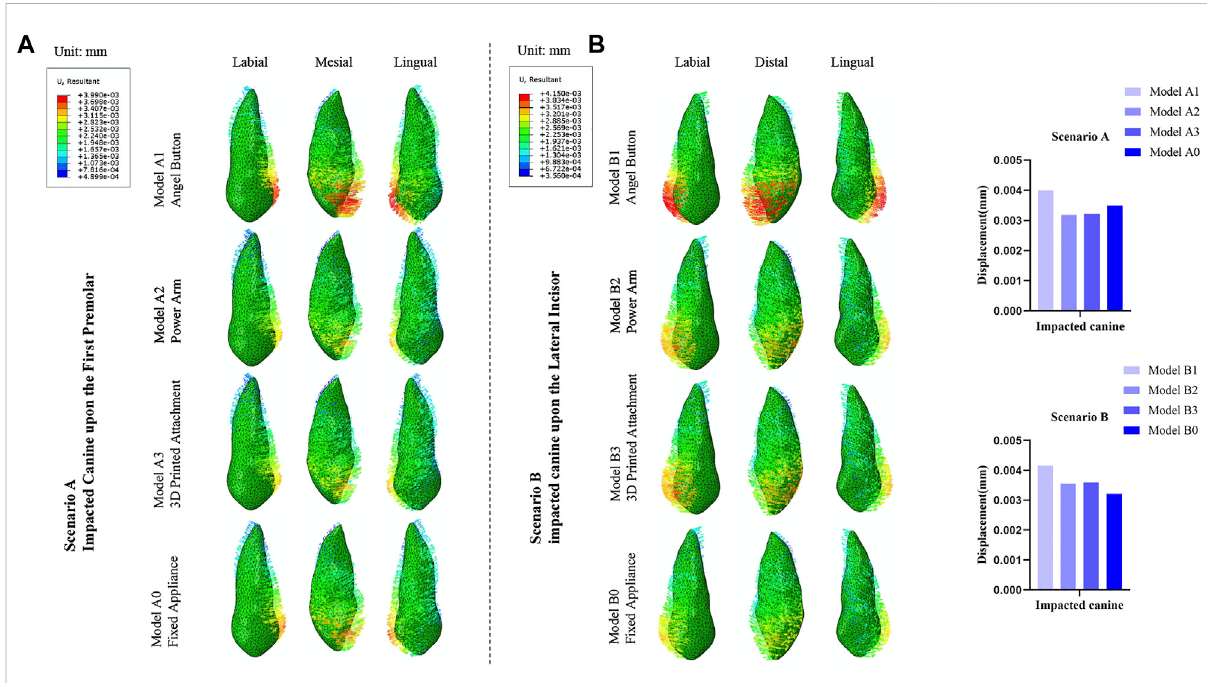
FIGURE 3 (A) Displacement tendencies of the impacted canine of Scenario A and Scenario B. (B) The maximum displacement of the impacted canine.